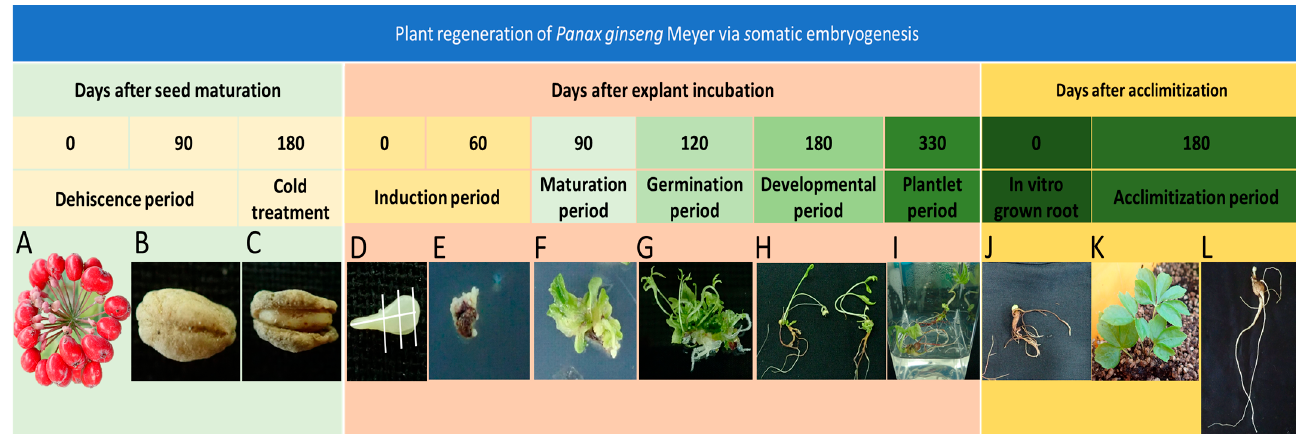
Figure 1. Micropropagation of P. ginseng via somatic embryogenesis. ( A ) Fruits, ( B ) indehiscent seed after sarcocarp removal, ( C ) dehiscent seed after dehiscence, ( D ) mature zygotic embryo before excision, ( E ) induced somatic embryos after inoculation of induction medium, ( F ) matured somatic embryos after transfer to maturation medium, ( G ) germinated somatic embryos after culture of germination medium, ( H , I ) well-developed regenerated plantlets after several months of in vitro cultivation, ( J ) in vitro-grown root derived from the in vitro culture process, ( K ) sprouted in vitro-grown root, and ( L ) 2 year old IGRs after acclimatization.